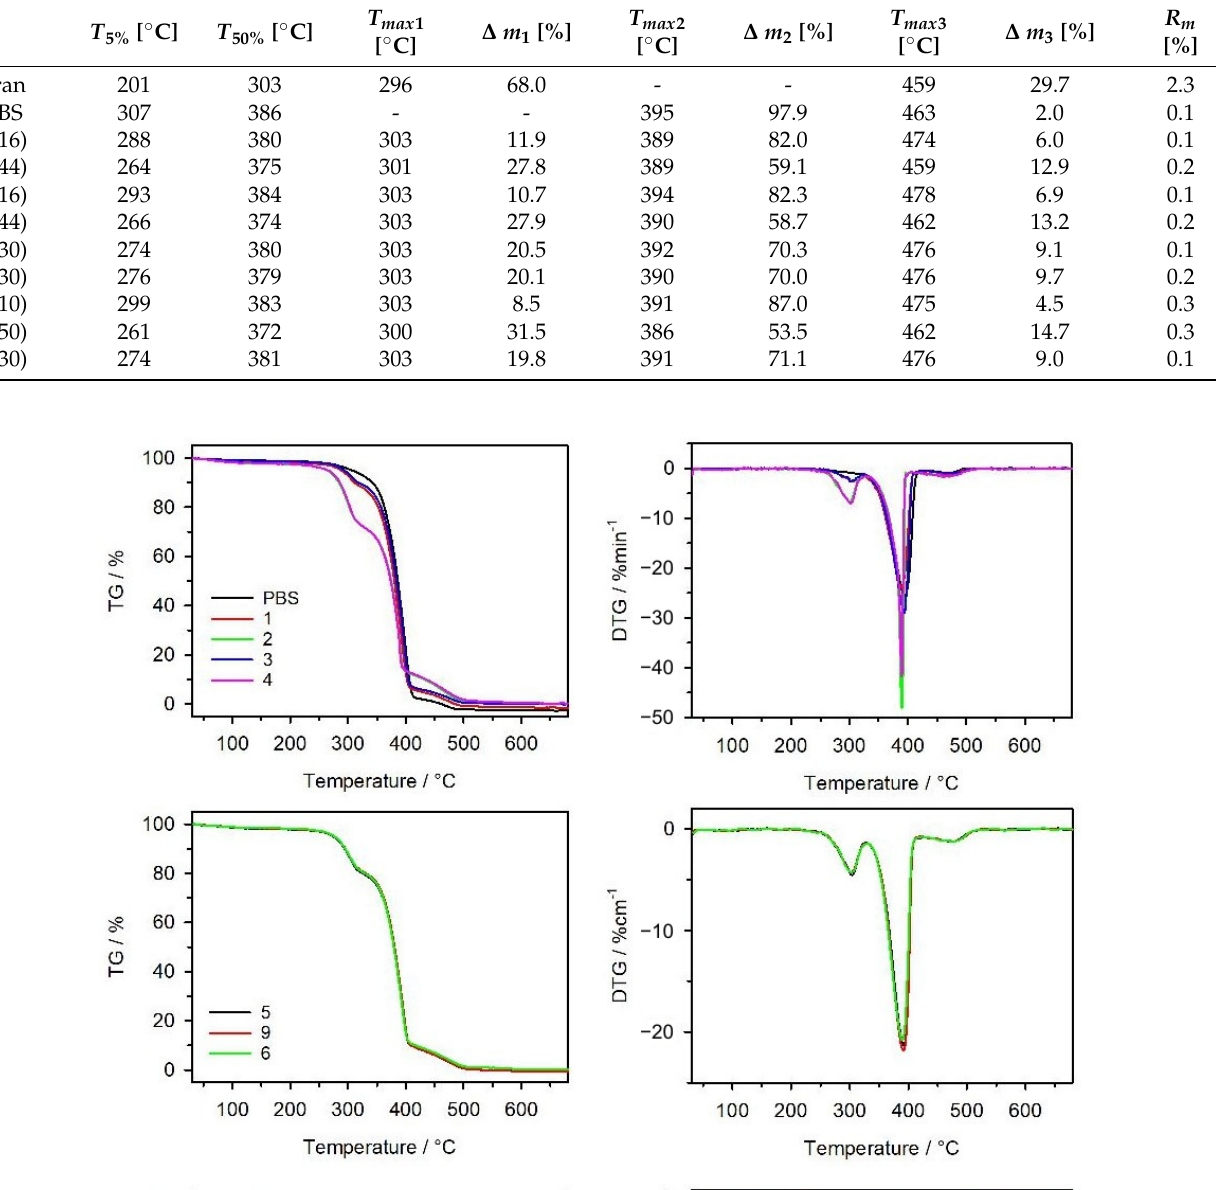
Table 8. Parameters characterizing the thermal stability of PBS, bran, and biocomposites, obtained based on thermogravime- try (TG) and derivative thermogravimetry (DTG) curves.